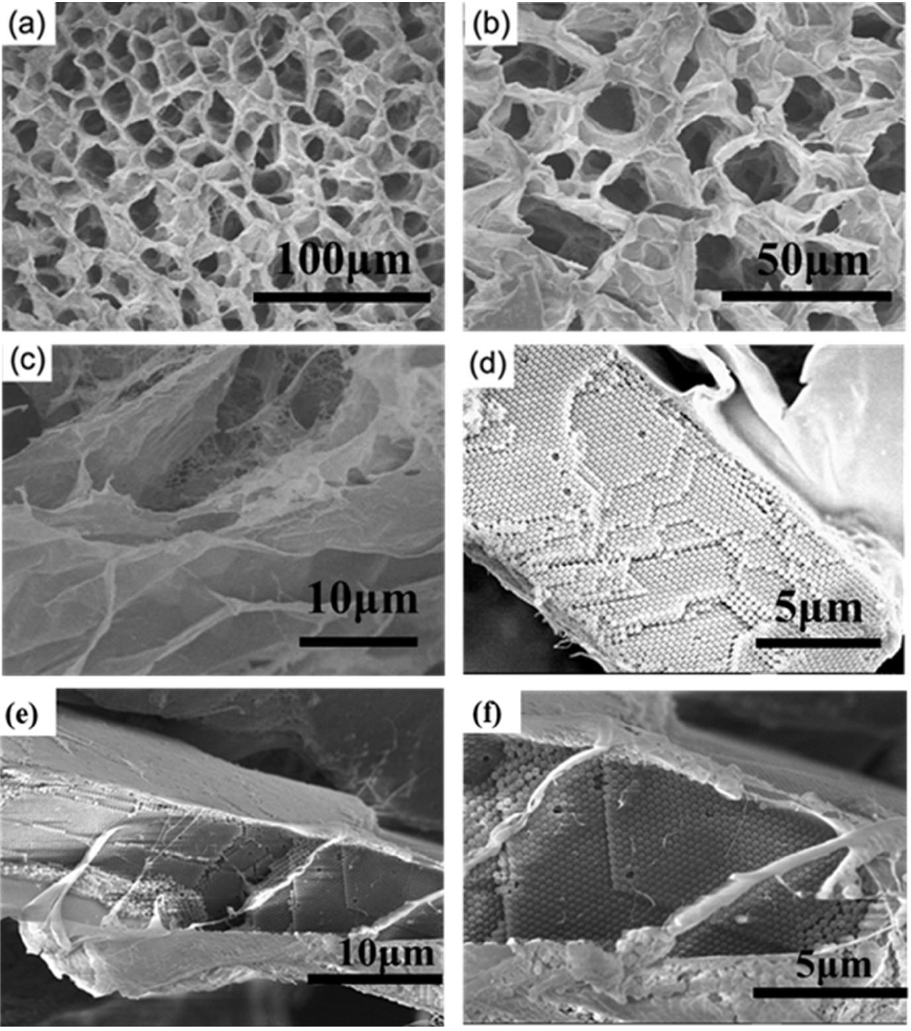
Figure 4. The SEM of freeze-dried the SF-PNIPAM dual-crosslinked nanocomposite film at −54 °C for 24 h ( a ) ×500; ( b ) ×1000; ( c ) ×3300; ( d ) ×7000; cross-section images ( e ) ×3700; ( f ) ×8000.